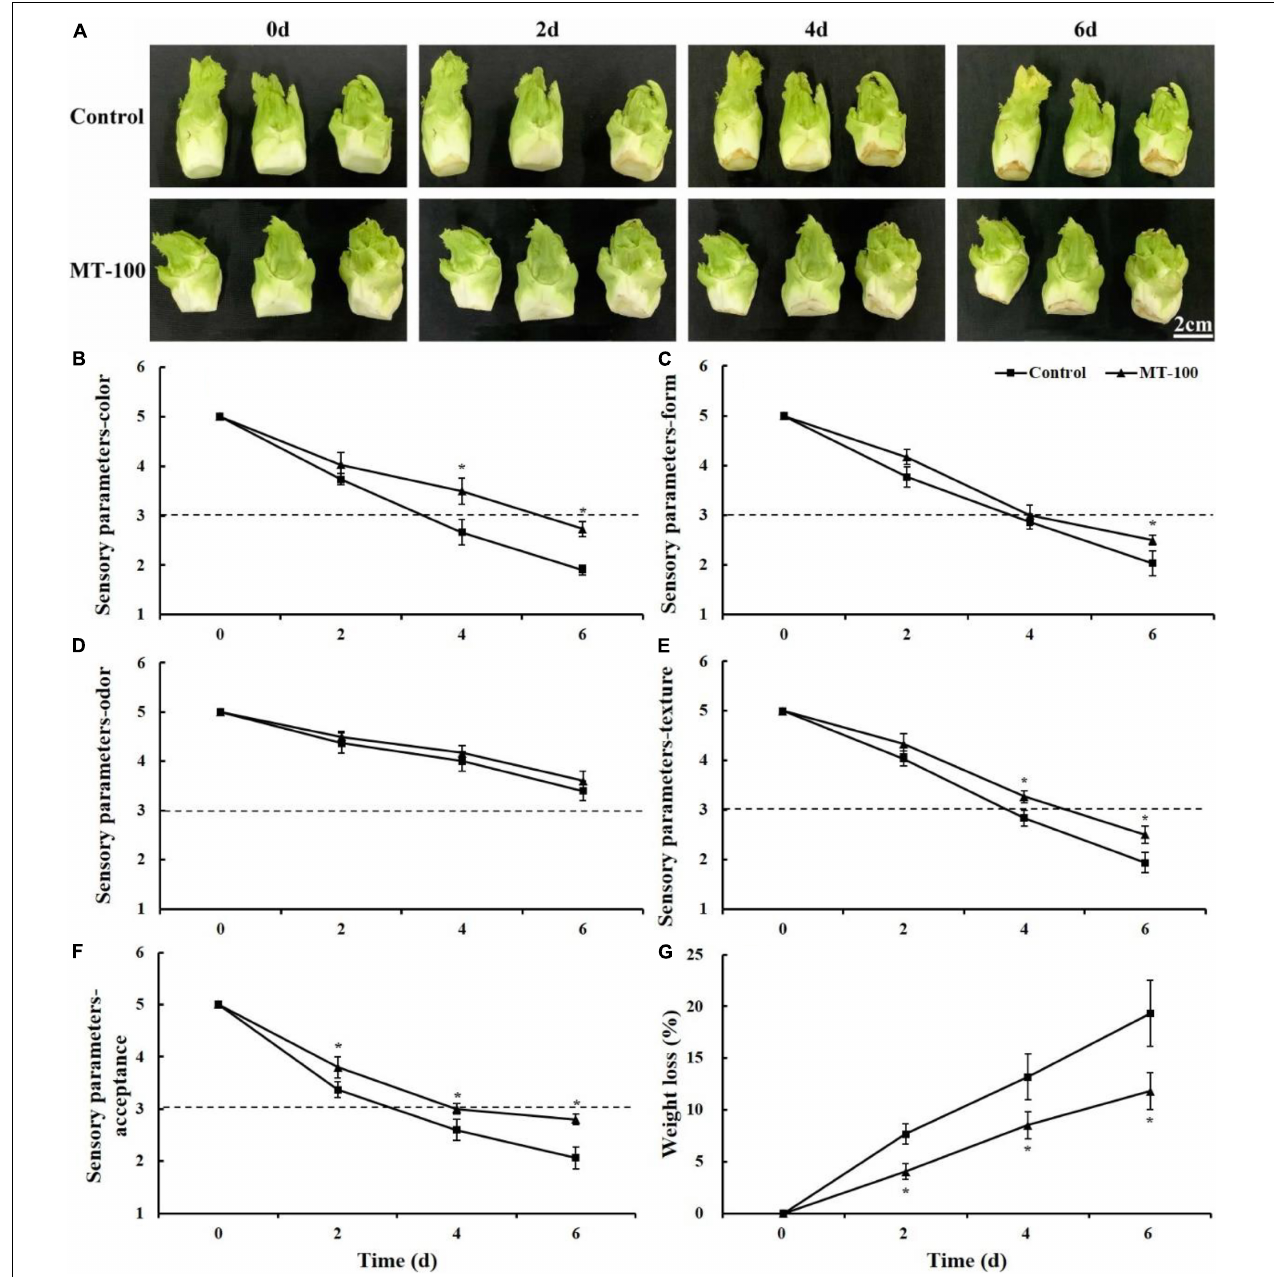
FIGURE 2 | Sensory quality and weight loss of 100 µ mol L − 1 melatonin-treated lateral buds of baby mustard during storage at 20 ◦ C. (A) Lateral buds of baby mustard at each sampling time. (B–F) Sensory parameters including color, form, odor, texture, and acceptance of lateral buds. (G) weight loss. MT-100, 100 µ mol L − 1 melatonin treatment. Each value is presented as the mean ± standard error of four biological replicates. Asterisks (*) indicate the significant differences ( P < 0.05) between control and melatonin-treated lateral buds during storage.